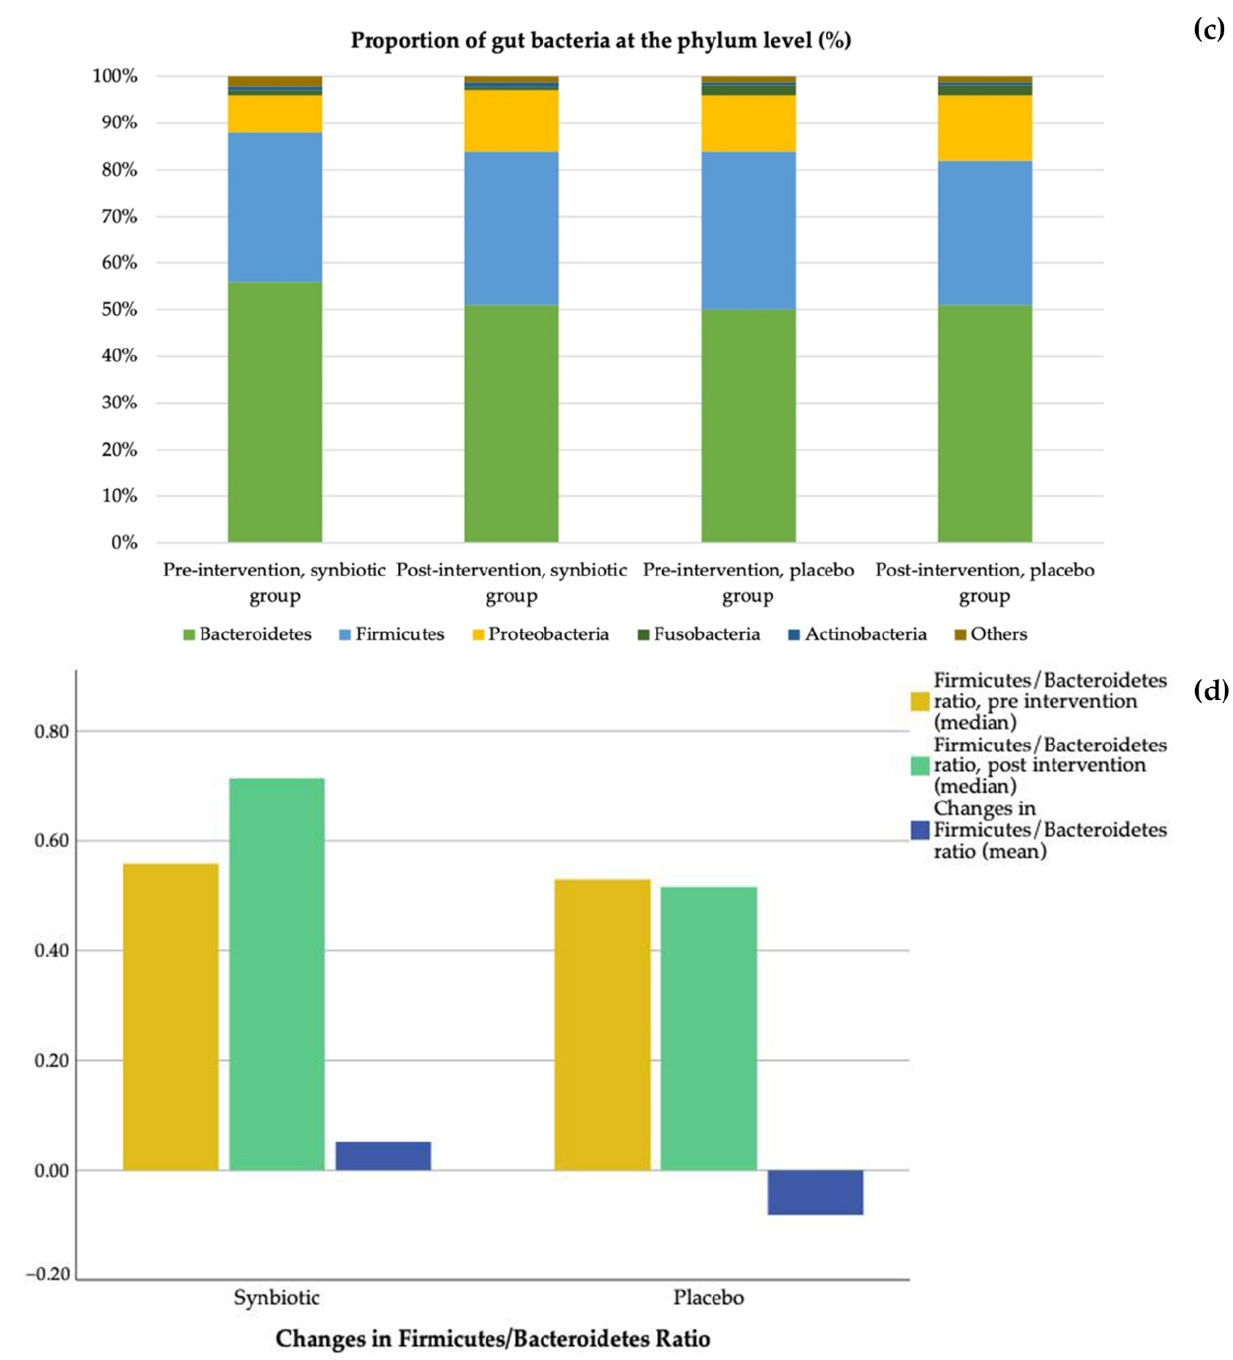
Figure 5. Changes in gut bacteria: ( a ) Class changes in the synbiotic group; ( b ) Class changes in the placebo group; ( c ) Comparison between the synbiotic and placebo group at the phylum level, before and after intervention; ( d ) Changes in Firmicutes/Bacteroidetes ratio.